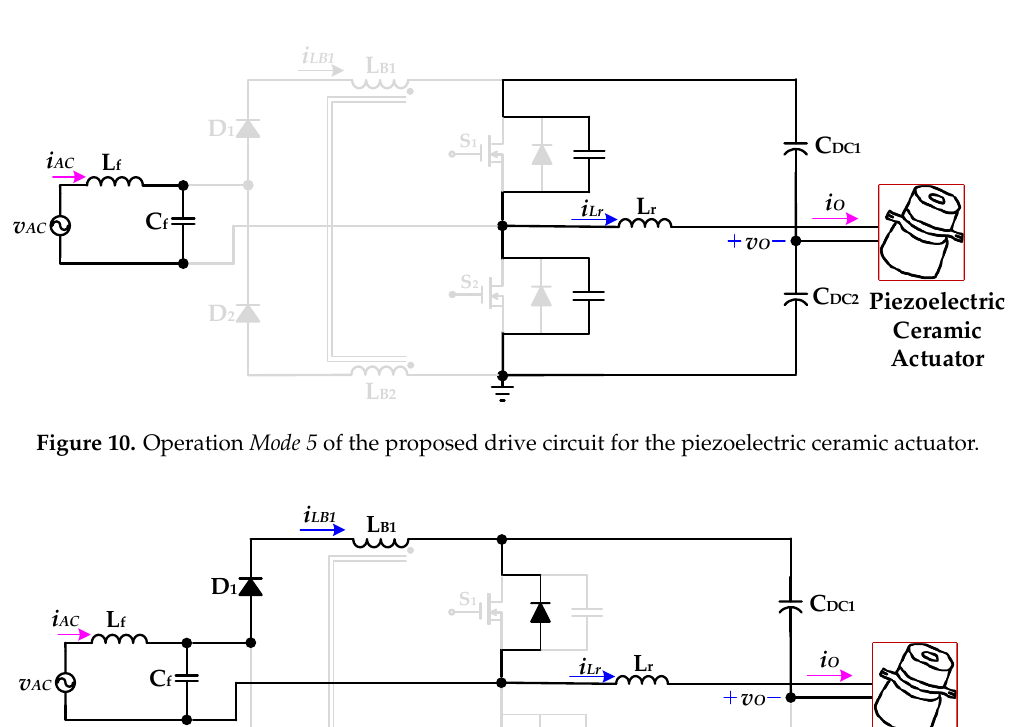
Figure 10. Operation Mode 5 of the proposed drive circuit for the piezoelectric ceramic actuator.